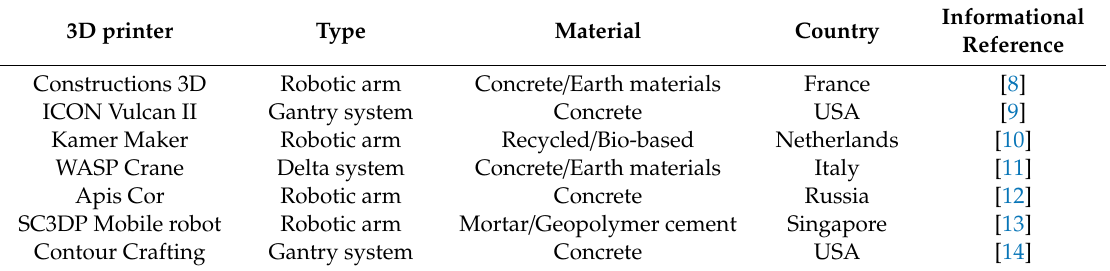
Table 1. Major additive manufacturing technologies for construction in the industrial and academic contexts.